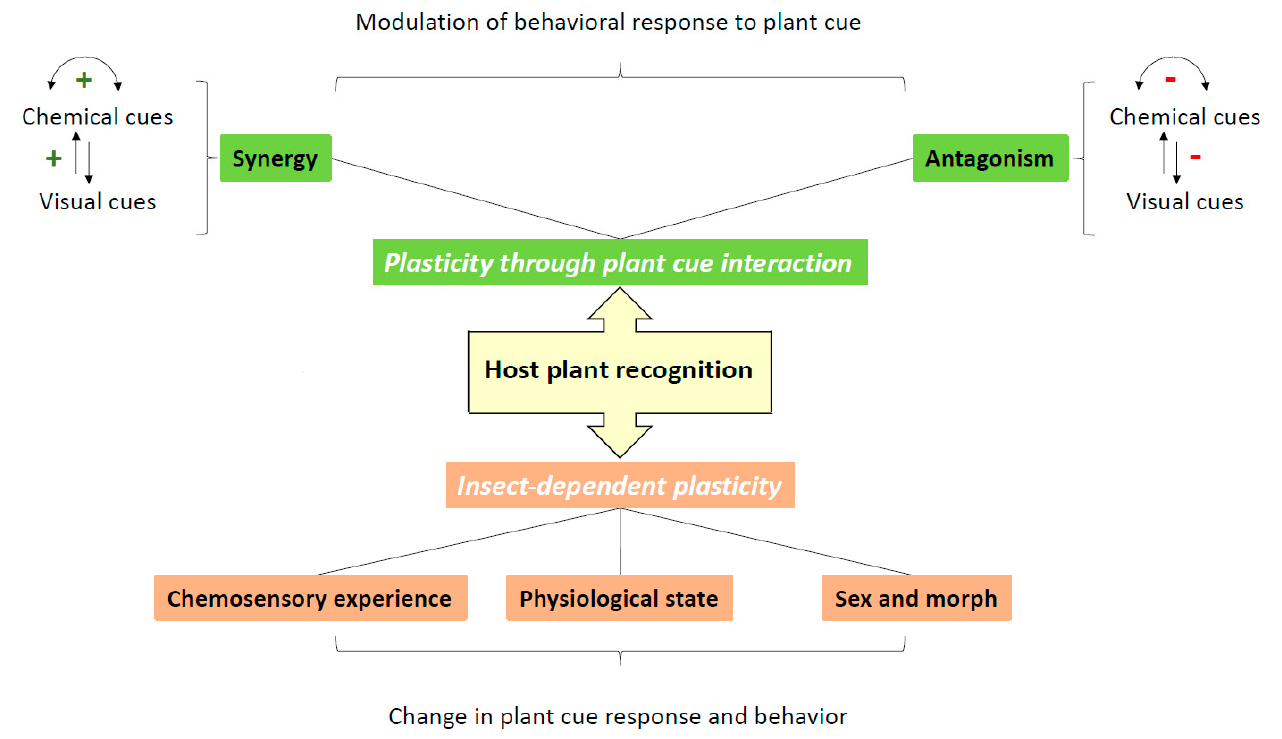
Figure 2. Overview over the different origins of plasticity in host plant recognition.